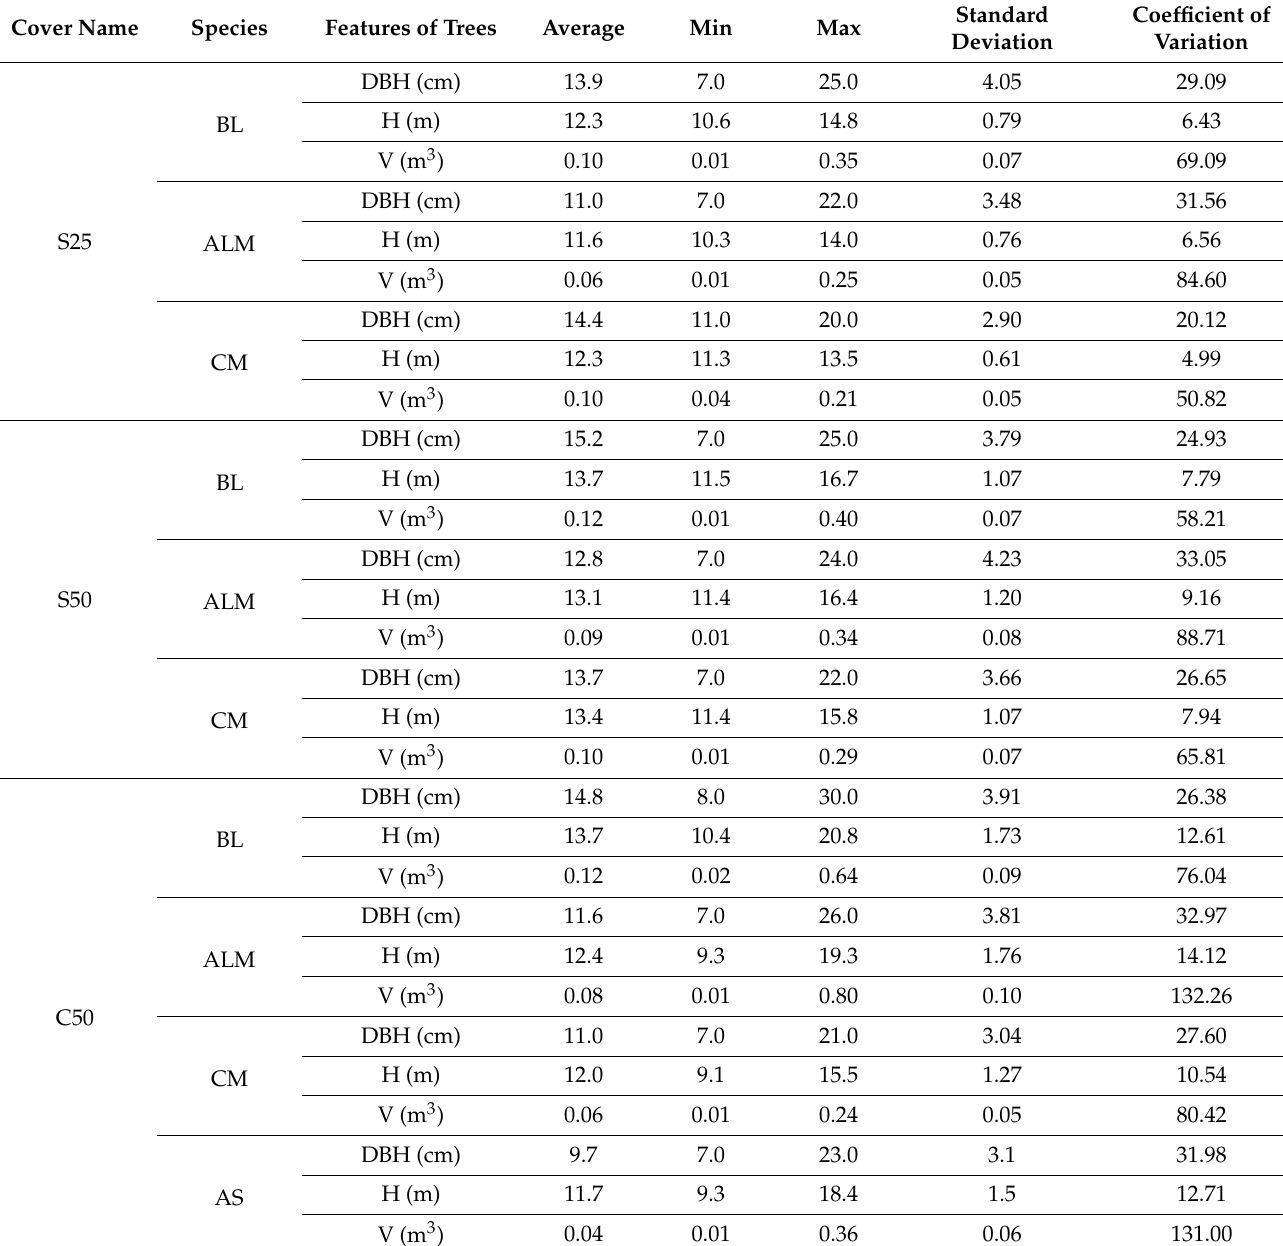
Table 2. Statistical characteristics of the studied tree species in individual groups of research